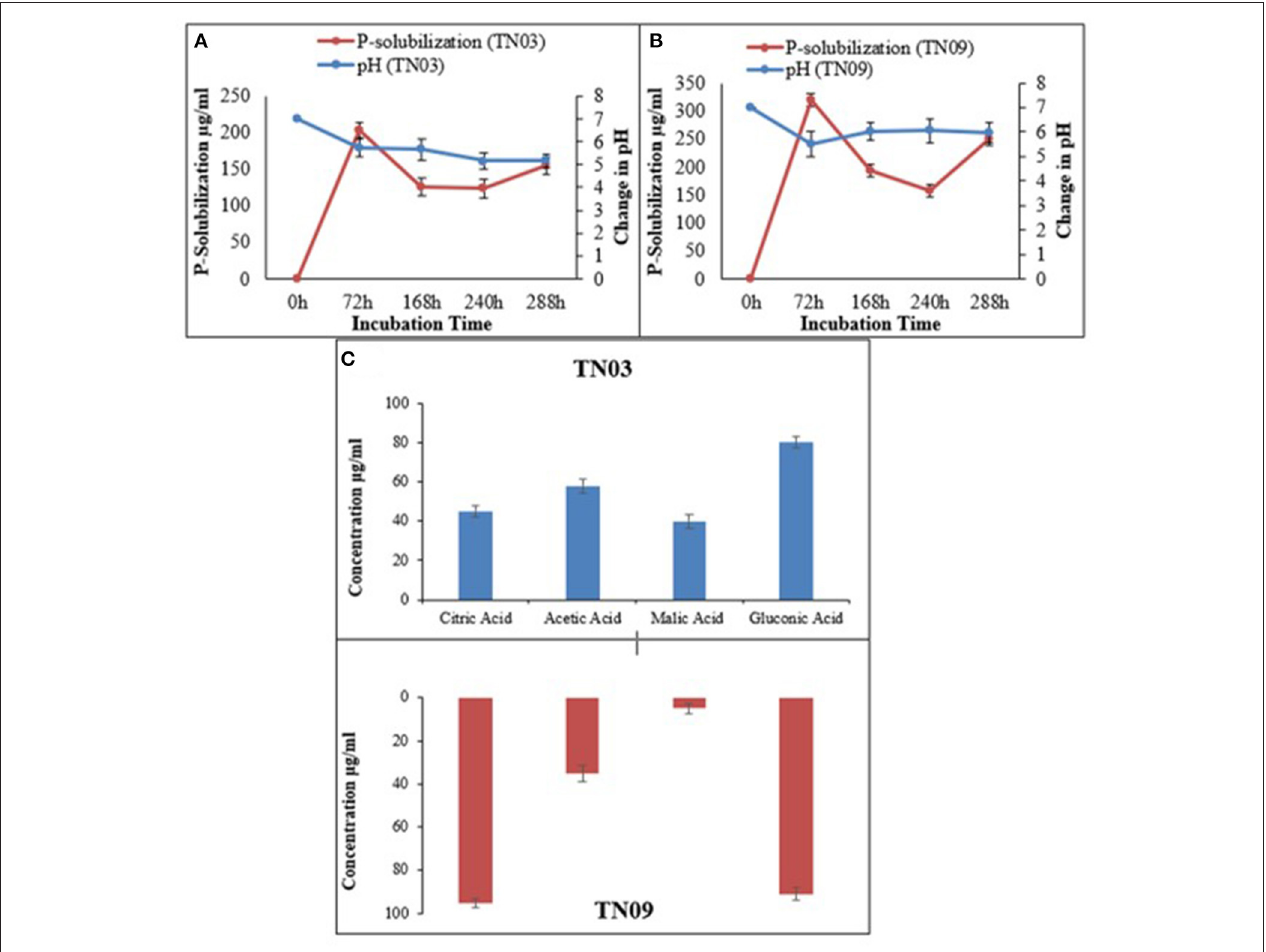
FIGURE 1 | Relationship between phosphate solubilization and pH change of Azospirillum spp. strains (A) TN03; (B) TN09; in Pikovskaya’s media; and (C) organic acid production.